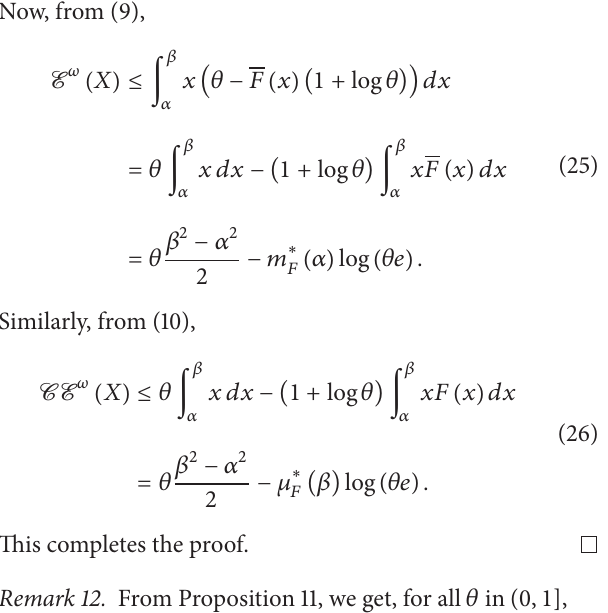
Figure 1: WCRE, WCE, and variance for Weibull